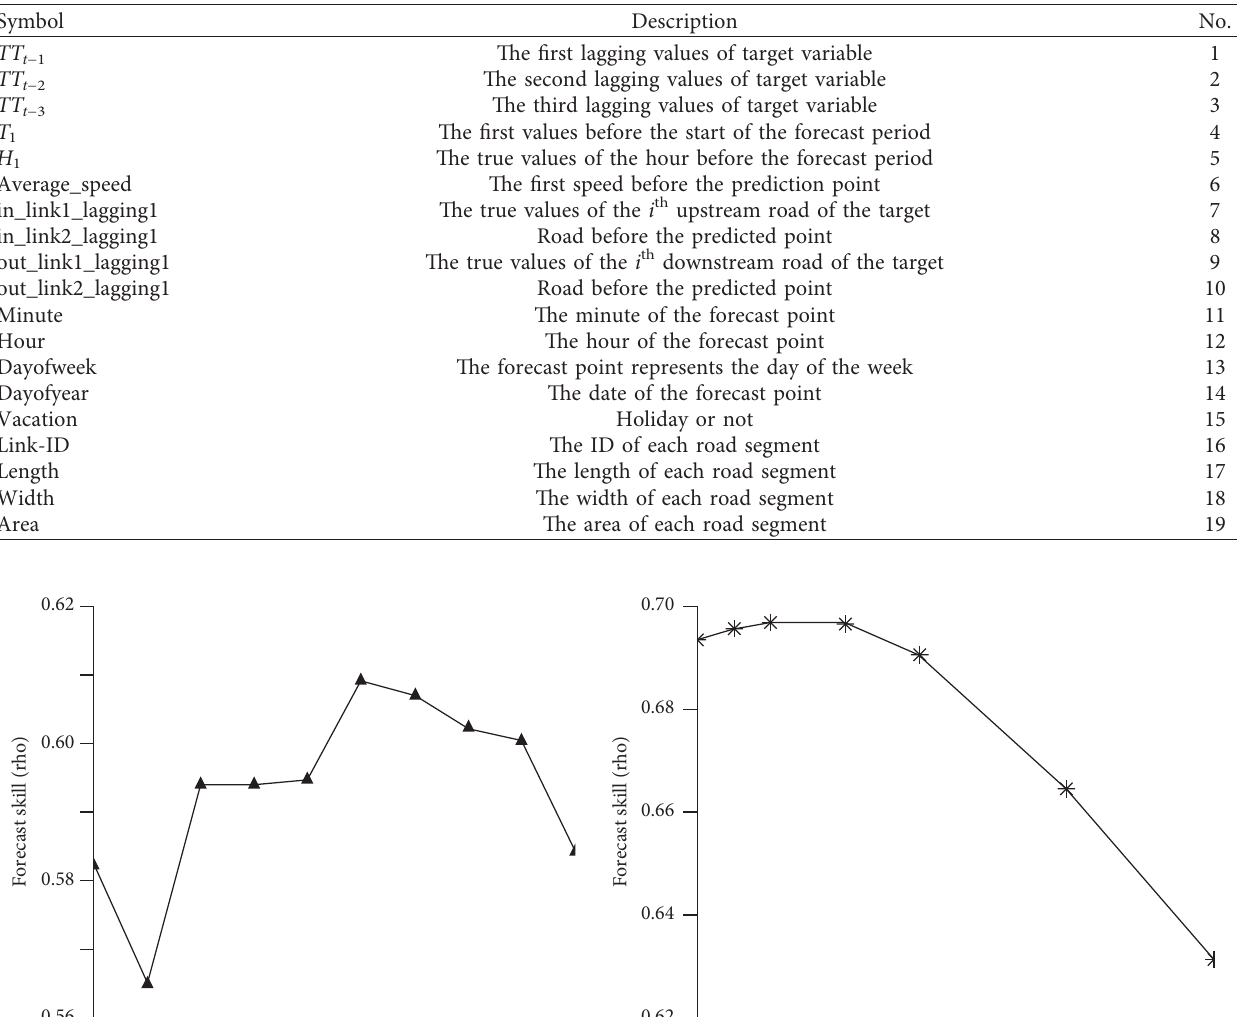
Table 1: The basic spatio-temporal